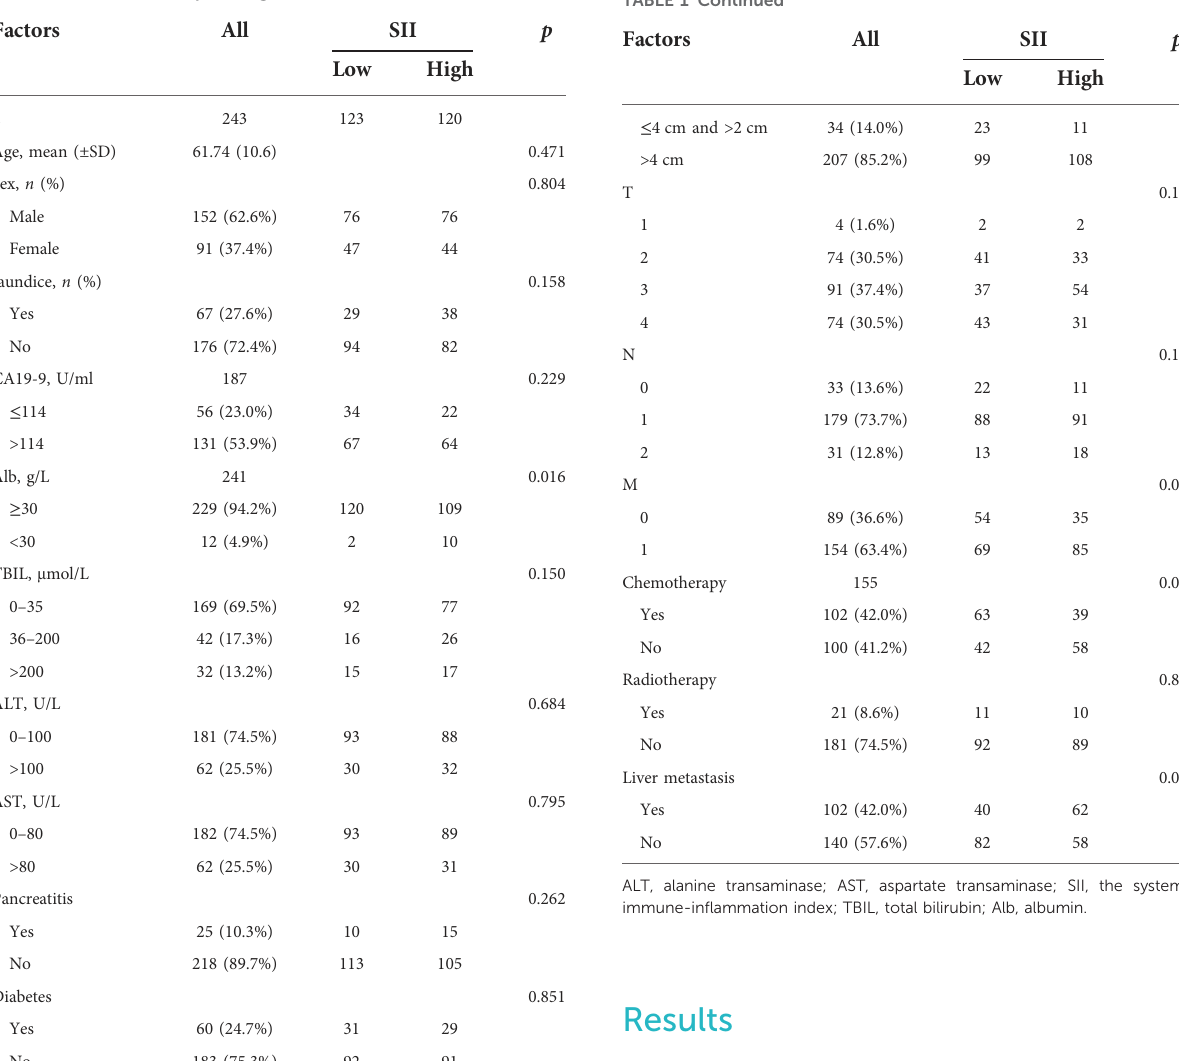
TABLE 1 Baseline clinicopathological